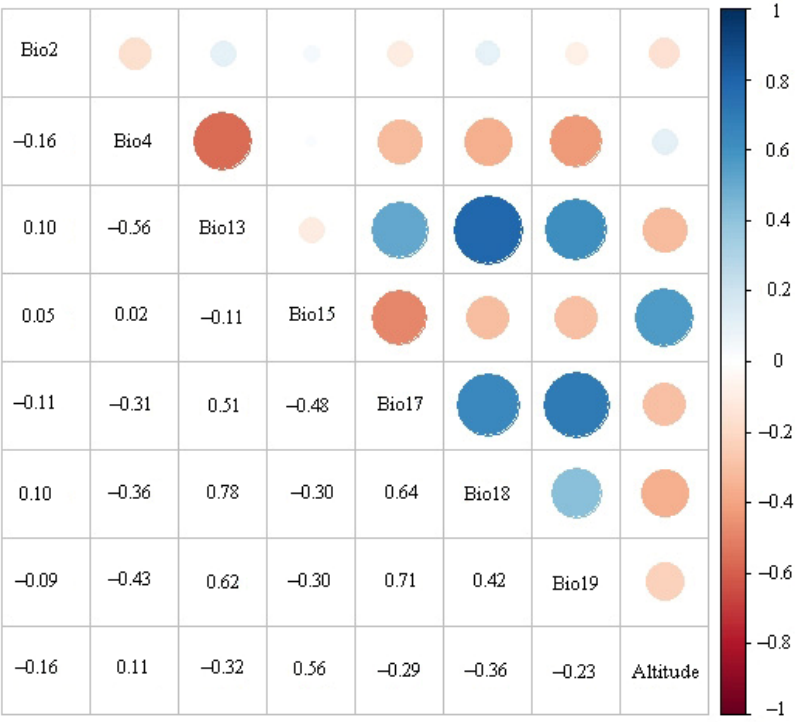
Figure 2. Pearson correlation coefficients for the eight environmental variables retained for MaxEnt modeling.